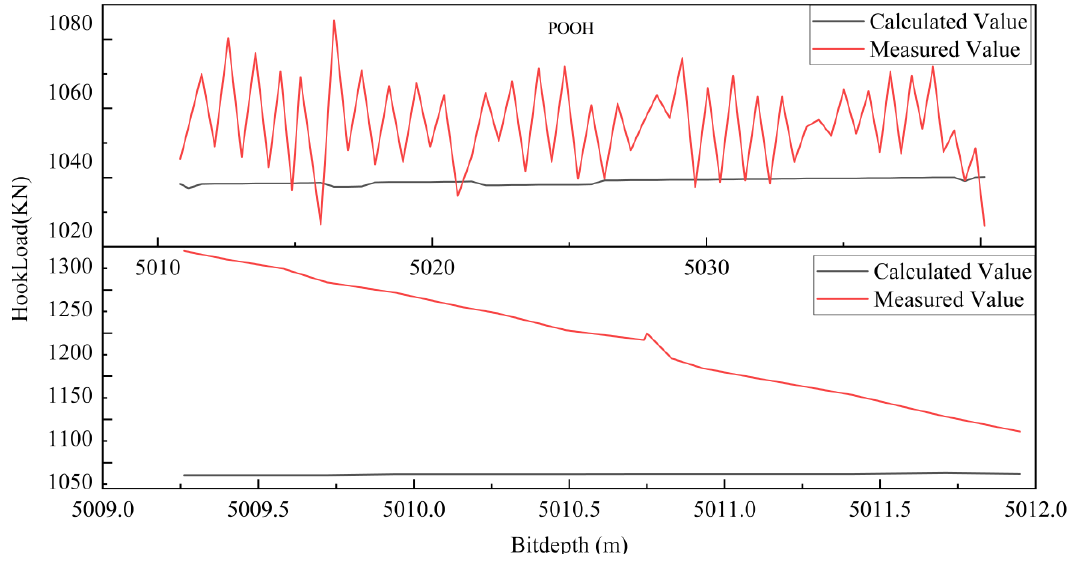
Figure 12. Stuck degree of POOH data for well N.